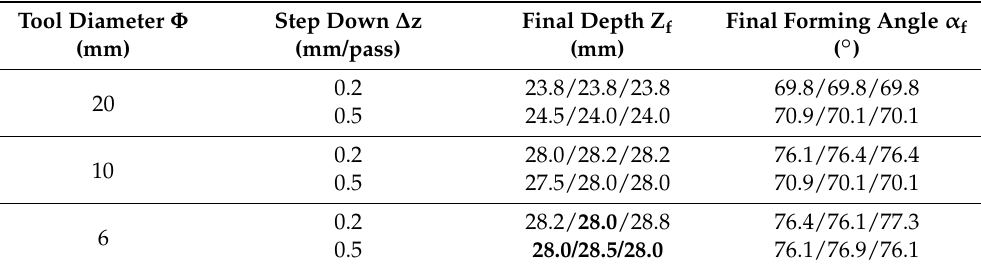
Table 2. Experimental plan of SPIF tests.